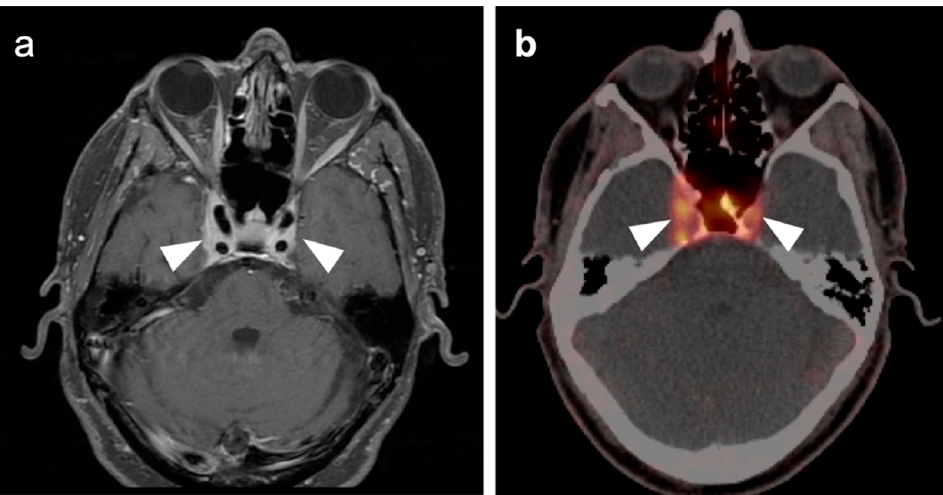
Figure 51. Meningioma on 64 Cu DOTATATE (Detectnet ® ) PET ‐ CT. ( a ) An axial Gd+ fat saturation T1 MRI image shows bilateral enhancing masses in the cavernous sinuses (white arrowheads). ( b ) 64 Cu DOTATATE (Detectnet ® ) PET ‐ CT demonstrates concordant increased uptake in the meningioma in the bilateral cavernous sinus (white arrowhead).